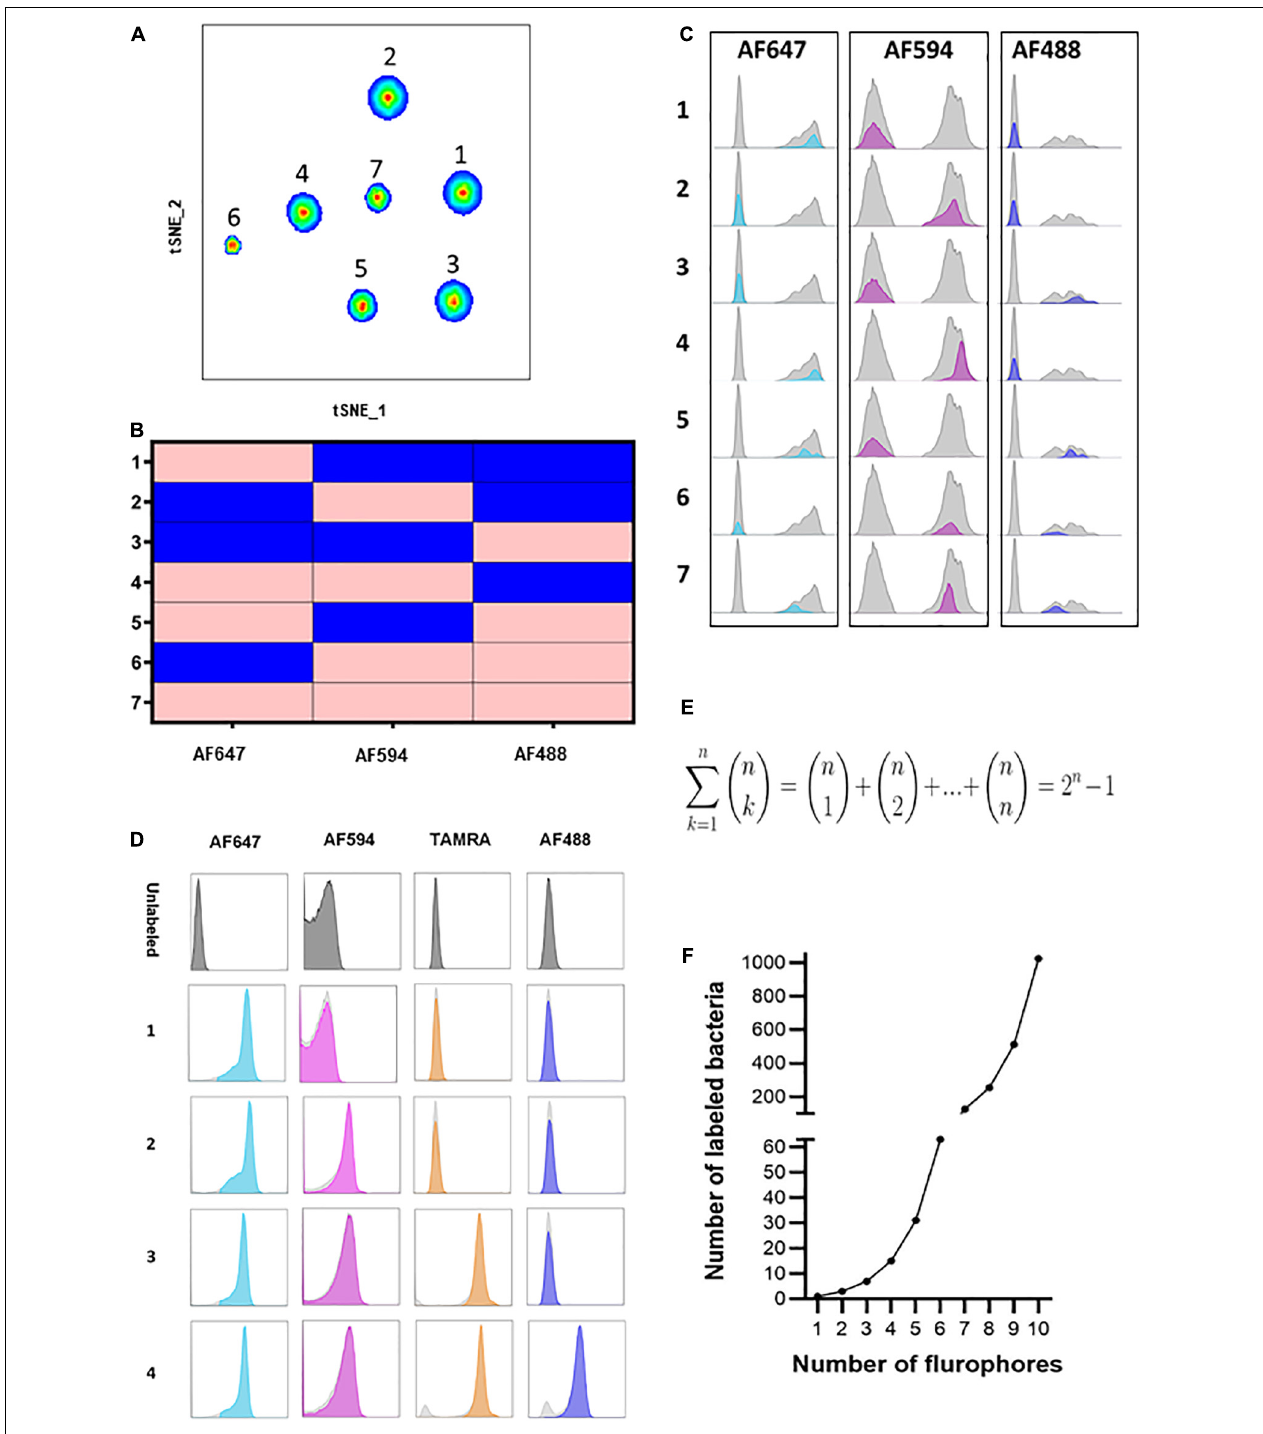
FIGURE 3 | Heterogeneous COMBICK labeling enables analysis of high-order and diverse bacterial consortia. (A) Flow cytometry t-SNE plot analysis of 7 different B. fragilis strains (YCH46, 1262, ATCC 23745, NCTC 2429, NCTC 9343, 2244, and CL03T00C08, respectively) labeled with 7 different single, dual and triple fluorophore combinations (AF488, AF594, and AF647). (B) Matrix demonstrating the single, dual and triple label of each of the 7 different B. fragilis strains identified in panel (A) and analyzed by flow cytometry. Pink represents positive labeling and blue negative. (C) Histograms of the 7 different B. fragilis strains analyzed in panel (A) . (D) Representative flow cytometry histograms of B. fragilis labeled with 1, 2, 3, and 4 fluorophores simultaneously. (E) Equation representing the number of all possible bacteria labeling combinations with “n” fluorophores. (F) Simulation of the equation described in panel (E) .